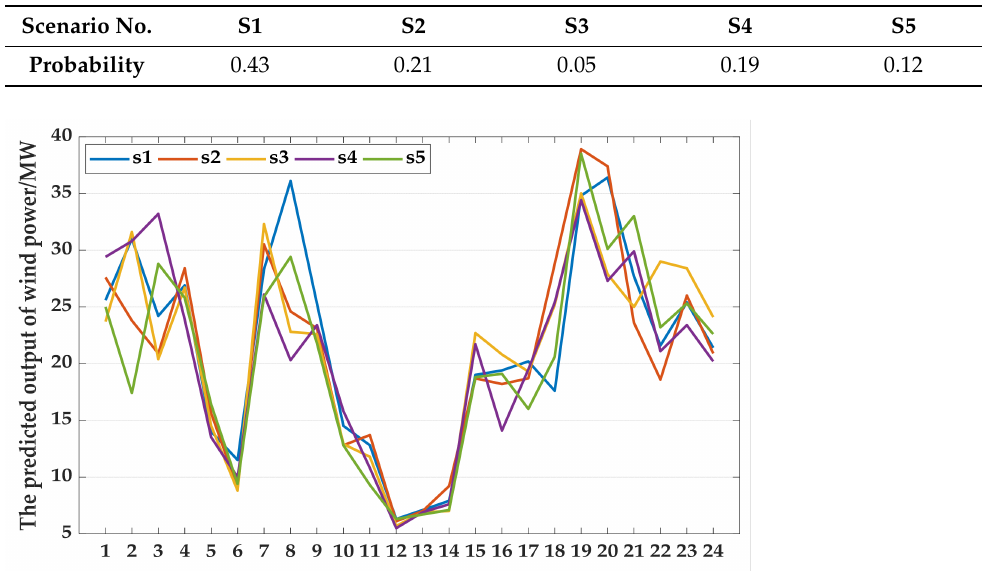
Table 5. Probability of each uncertain wind power scenario.